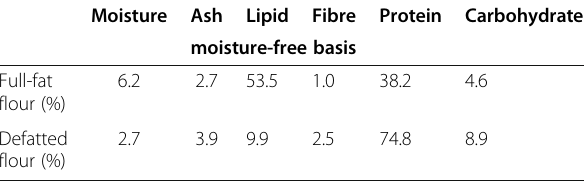
Table 2 Nutritional compositions of full-fat and defatted CMS flour samples Moisture Ash Lipid Fibre Protein Carbohydrate moisture-free